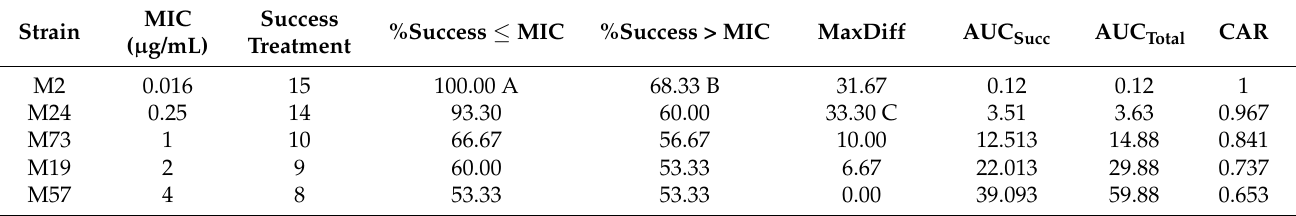
Table 5. The CAR and MaxDiff results of WindoW analysis for five strains of different MIC.